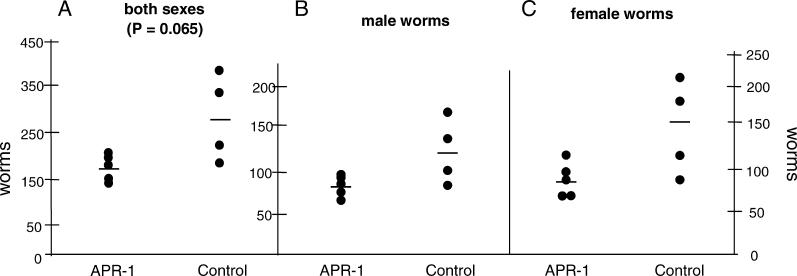
Vaccination with APR-1 Reduces Adult Worm Burdens of Dogs after Challenge Infection with HookwormsStatistically significant reduction at the p < 0.1 level (p = 0.065) in median adult worm (both sexes) burdens of dogs vaccinated with APR-1 compared to dogs that received adjuvant alone (A). Reductions are also shown when only male (B) (p = 0.111) and only female (C) (p = 0.1905) worms were considered; however, statistically significant reductions were not achieved for single sex analyses. Bars represent the median value for each group.